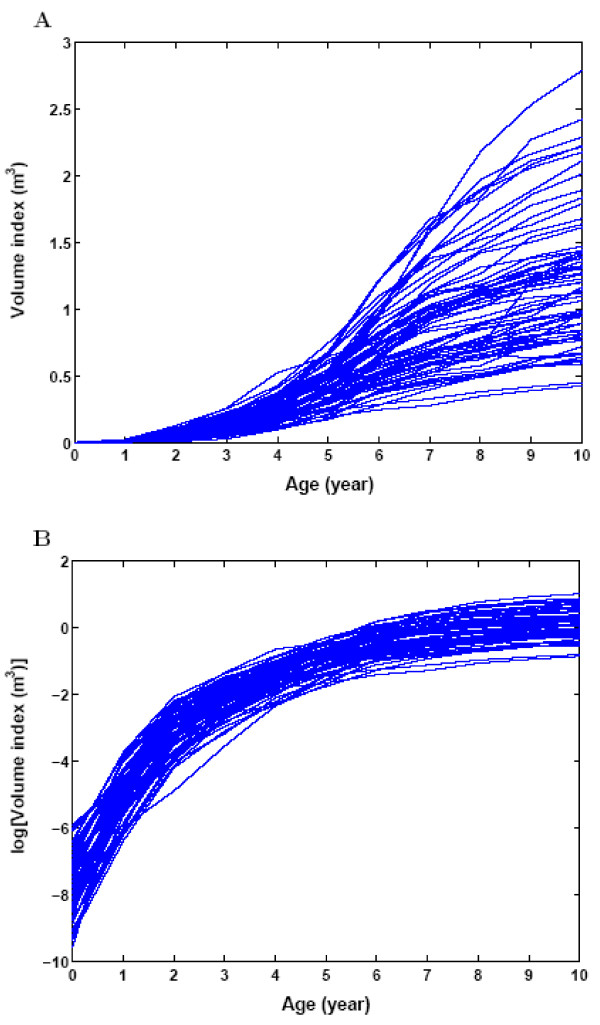
Plots of stem volume index growth vs. ages for each of the 90 genotypes used to construct linkage maps in poplar hybrids (Yin et al. 2002). The relationships between growth and age are displayed for untransformed (A) and log-transformed data (B).